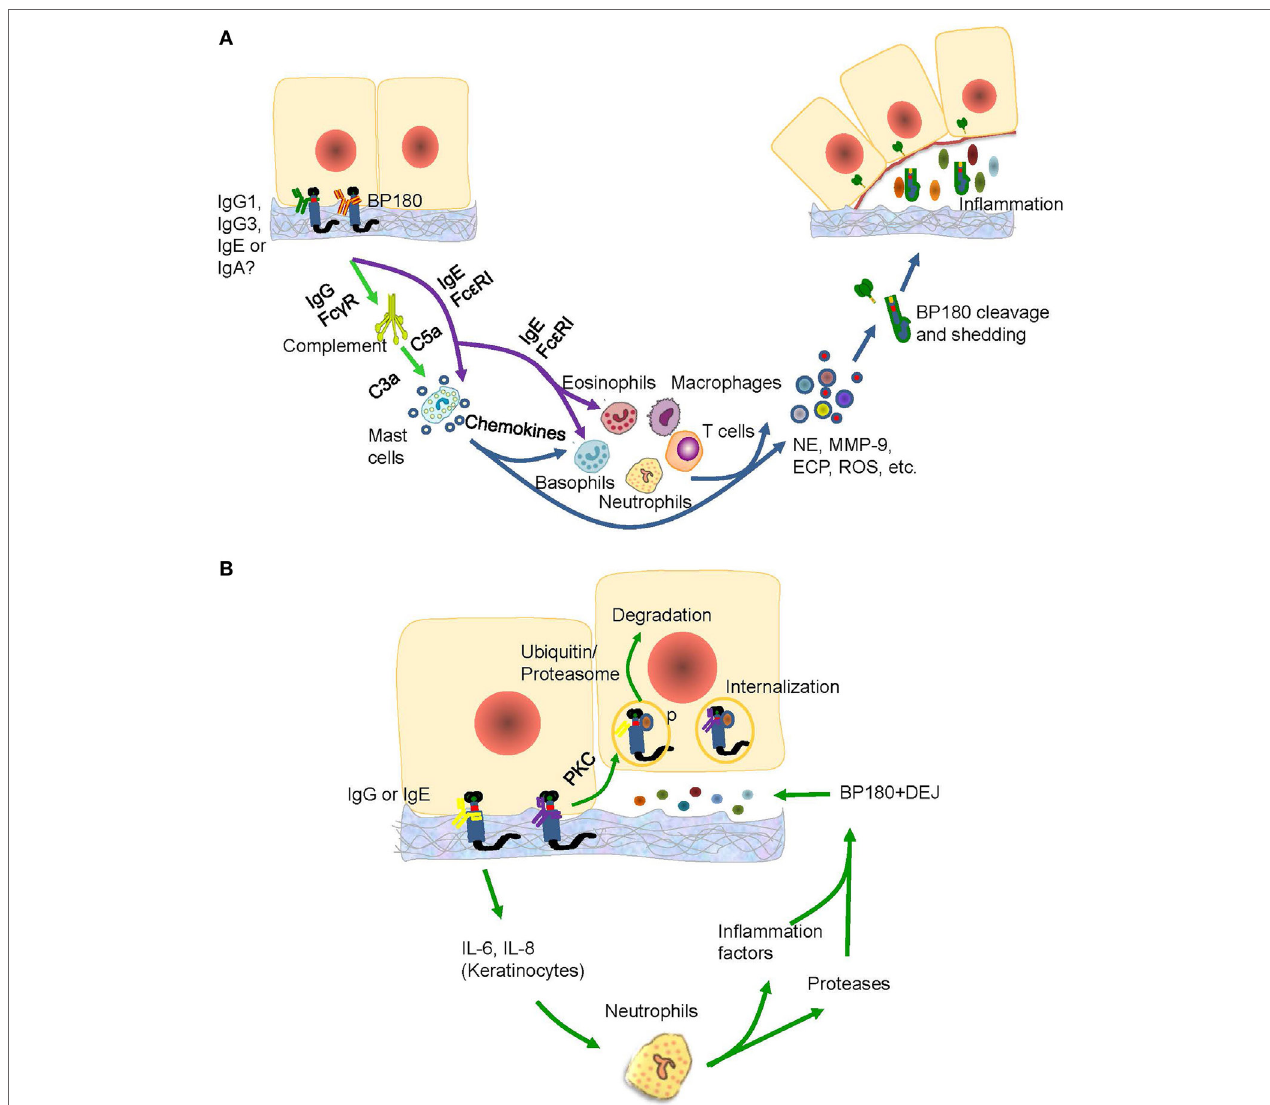
FigURe 3 | The possible pathogenic mechanism of the anti-BP180 NC16A autoantibodies. (A) The IgG1, IgG3, IgE, or IgA anti-BP180 NC16A autoantibodies- mediated pathways for blister formation in bullous pemphigoid (BP). The binding of IgG1, IgG3 with NC16A activates complements via Fc γ R followed by mast cell degradation and neutrophilic, eosinophilic, basophilic, and macrophage infiltration, which lead to the degradation of BP180 by releasing inflammatory factors and proteases. While the IgE anti-BP180 NC16A autoantibodies activate infiltration of mast cell, eosinophils, and basophils via Fc ε RI. (B) The immunoglobulin G (IgG) or IgE-mediated pathways for blister formation in BP. On the one hand, the binding of IgG or IgE with NC16A domain activates the protein kinase C followed by BP180 phosphorylation and degradation, which leads to the reduced adhesion. The binding, on the other hand, causes the release of interleukin (IL)-6 and IL-8 by keratinocytes, which prompts recruitment of neutrophils, release of inflammatory factors and neutrophil elastase (NE), and blister